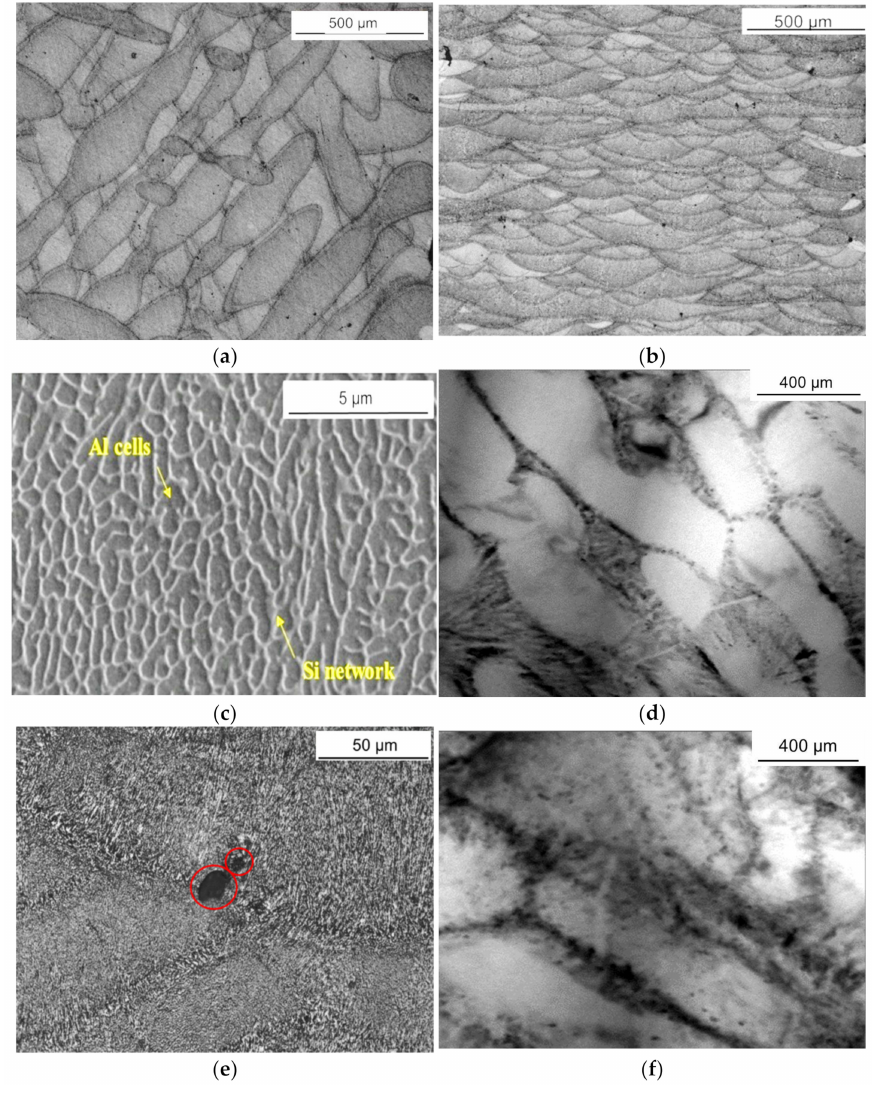
Figure 9. Laser scans on the surface of a AlSi10Mg sample printed by L-PBF ( a ); melt pools in the cross-section of the same sample ( b ); each grain inside the melt pool exhibits a finer substructure of cells decorated by eutectic ( c , d ); pores of micrometric ( e ) and nanometric ( f ) size. Micrographs are taken from ref. [109] and other unpublished works of the present authors ( b , c , e reproduced with permission from Journal of Alloys and Compounds; published by Elsevier,